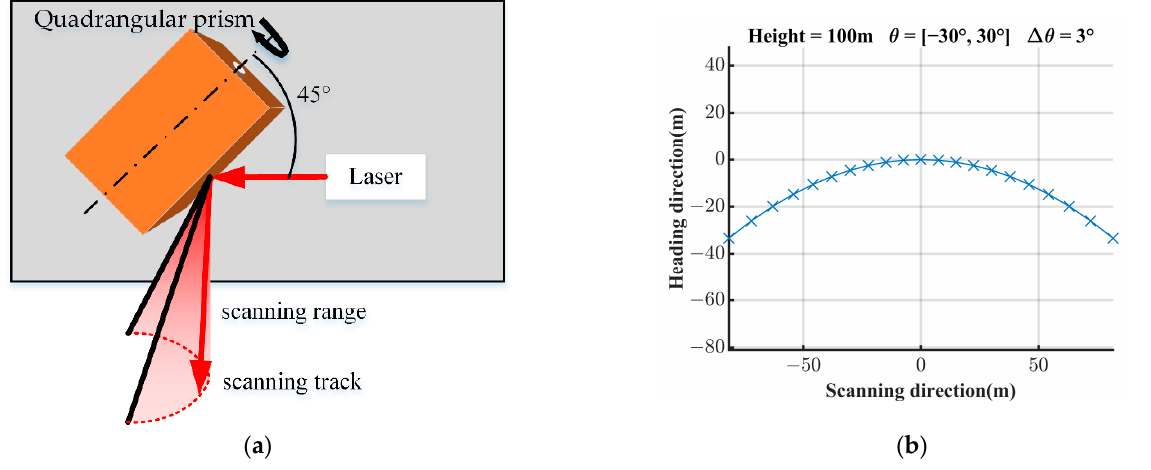
Figure 5. Quadrangular prism scanning mode 2. ( a ) Scanning schematic diagram; ( b ) Scanning track with a height of 100 m, a motor rotation angle of ±30° , and an interval angle of 3° between points.